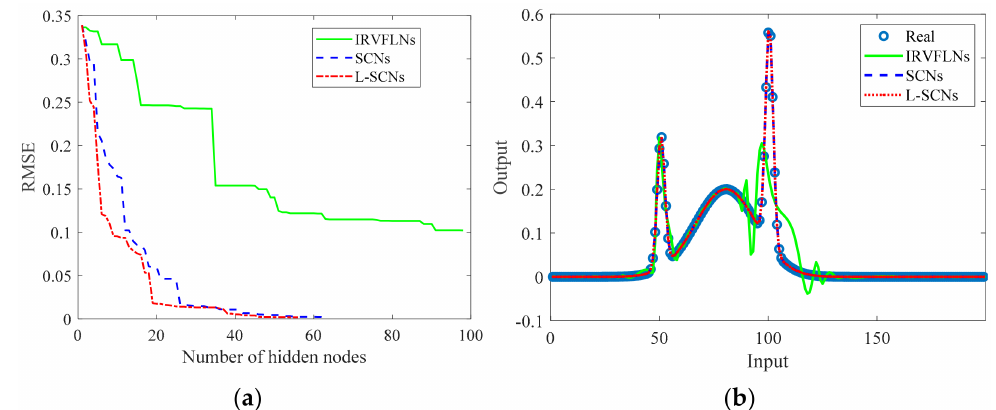
Figure 2. Training results of three algorithms. ( a ) Convergence Curve; ( b ) Fitting Curve.